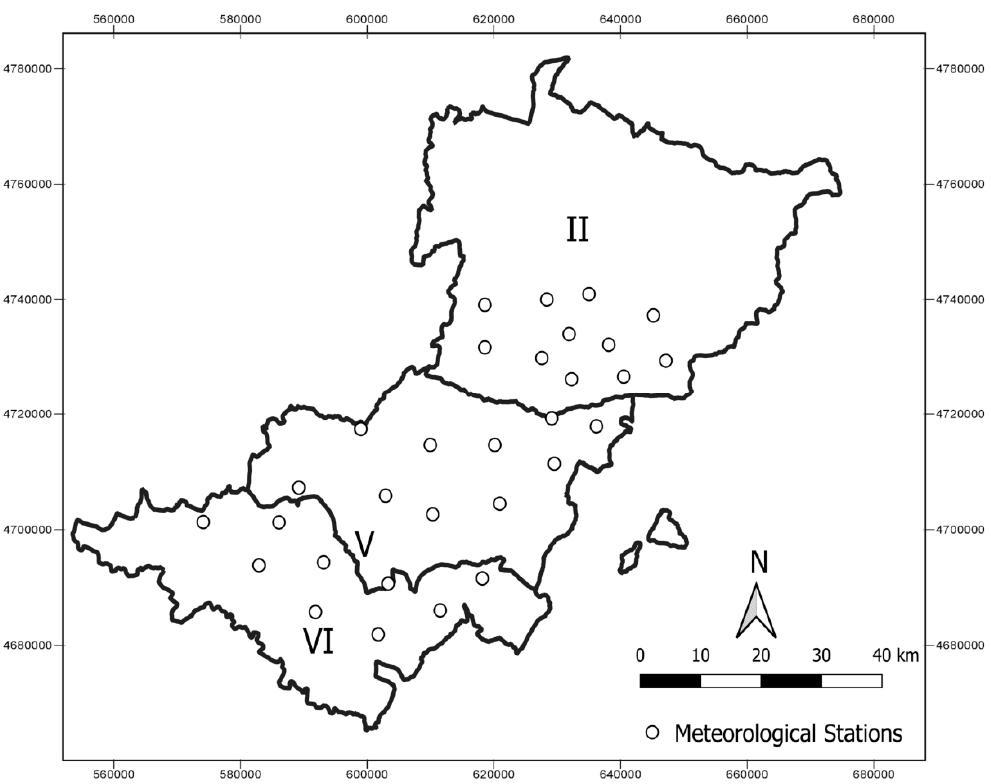
Figure 2. Meteorological station locations from which temperature and rainfall data was obtained for the three zones (II, V and VI). UTM coordinates are expressed in meters. Table 1. Growing degree days (GDD) and Zadoks scale [36] for the two analyzed